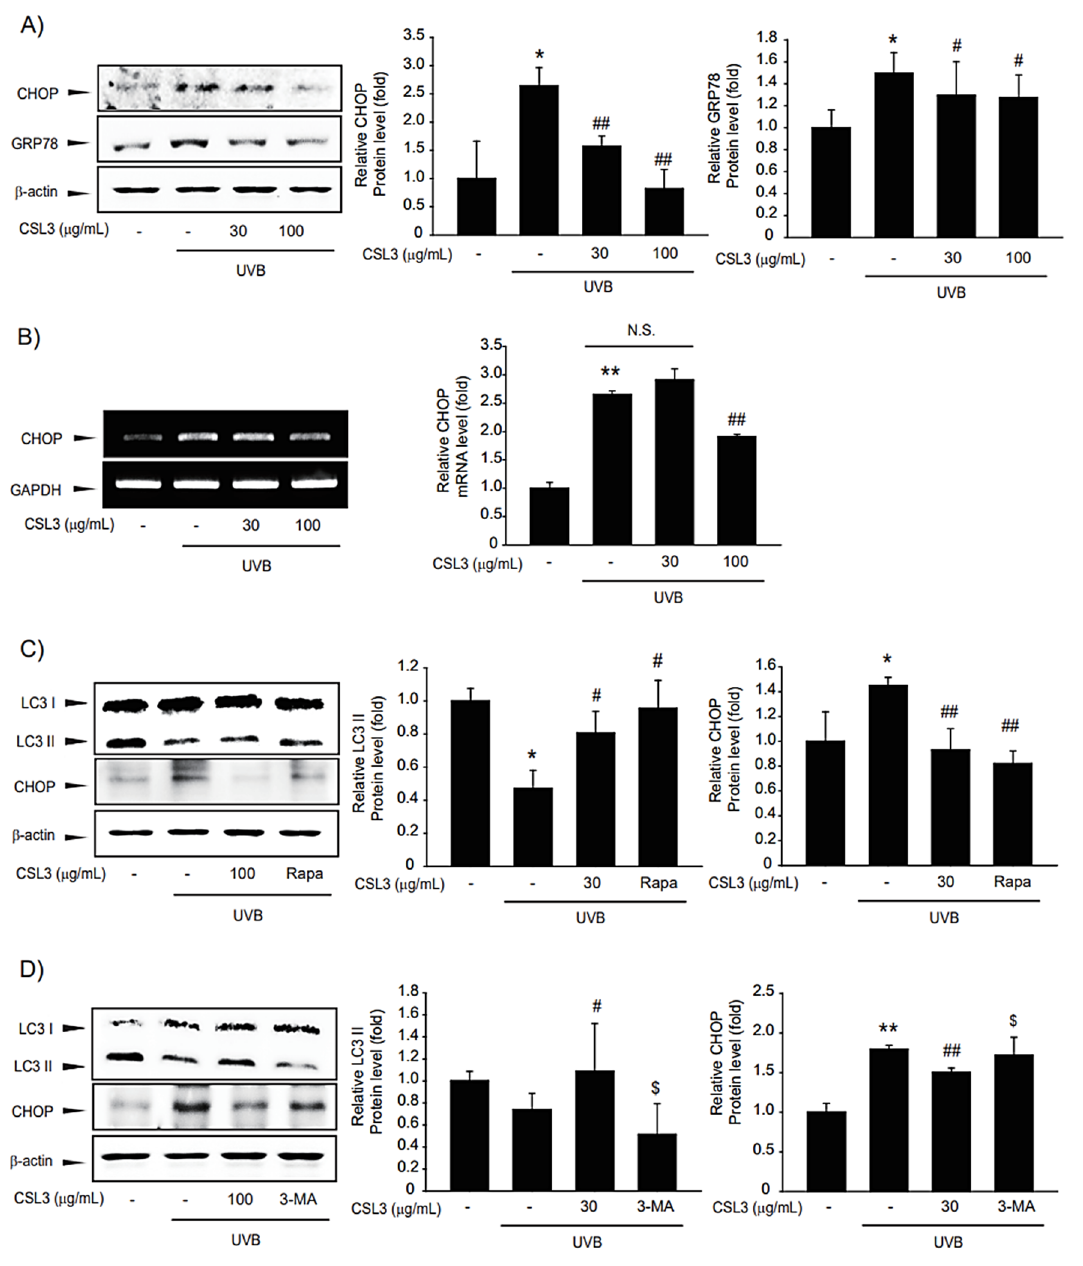
Figure 5. Effects of CSL3 on ER stress in HaCaT cells irradiated with UVB. ( A ) Effects of CSL3 on UVB-induced ER stress. First, we pre-treated with CSL3 (30–100 µ g/mL) for 1 h in HaCaT cells. Then, the cells were exposed to UVB irradiation (30 mJ/cm 2 ), followed by incubation with CSL3 for 3 h. ER stress marker proteins were visualized using immunoblotting. Data represent means ± S.E. of 3 replicates; significant when compared with respective controls, * p < 0.05, compared with the UVB irradiation group, # p < 0.05, ## p < 0.01. ( B ) RT-PCR analysis. We first pre-treated with CSL3 (30–100 g/mL) for 1 h in HaCaT cells. Then, the cells were exposed to UVB irradiation (30 mJ/cm 2 ), followed by incubation with CSL3 for 3 h. Data represent means ± S.E. of 3 replicates; significant when com- pared with respective controls, ** p < 0.01, compared with the UVB irradiation group, ## p < 0.01. N.S.—not significant. ( C ) We first pre-treated with CSL3 (100 g/mL) or rapamycin (500 nM) for 1 h in HaCaT cells. Then, the cells were exposed to UVB irradiation (30 mJ/cm 2 ), followed by incubation with CSL3 or rapamycin for 3 h. Expressions of LC3II and CHOP proteins were visualized using immunoblo(cid:308)ing. Data represent means ± S.E. of 3 replicates; significant when compared with re- spective controls, * p < 0.05, compared with the UVB irradiation group, # p < 0.05, ## p < 0.01. ( D ) HaCaT cells were pretreated with CSL3 (100 g/mL) or 3-MA (50 M) for 1 h. Cells were then